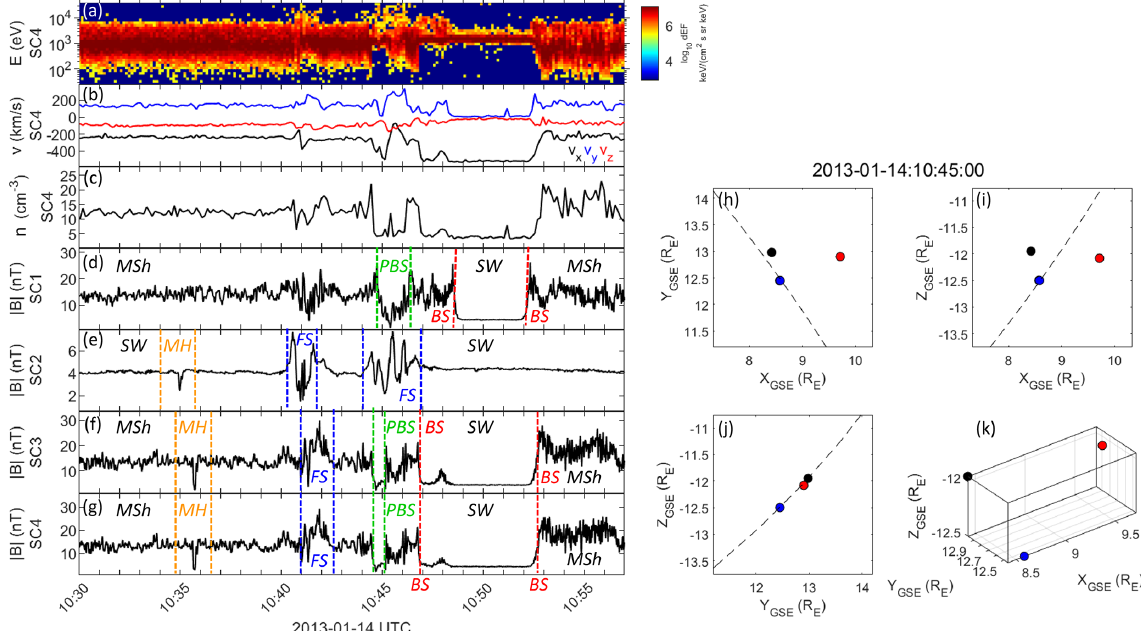
Figure 1. (a–c) Differential ion energy flux, ion velocity, and ion density for S/C 4, (d–g) magnetic field strength for S/C 1–4. Identified regions are marked with SW (solar wind), MSh (magnetosheath), MH (magnetic hole), BS (bow shock), FS (foreshock and magnetosheath downstream of the foreshock), PBS (partial bow shock), see text for further details. (h–k) Spacecraft positions in various GSE (Geocentric Solar Ecliptic) coordinate projections. The spacecraft are identified by the standard Cluster colour code; S/C 1 – black, S/C 2 – red, S/C 3 – green, S/C 4 – blue. S/C 3 and 4 are so close that they cannot be separated on the scale of these plots.